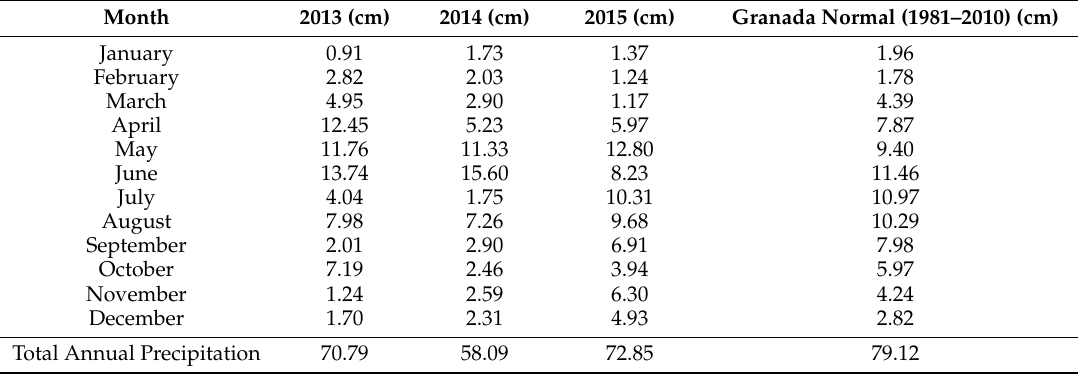
Table 6. Monthly rainfall totals during the years 2013–2015 with comparison to the Normal (30 year average) for Granada, Minnesota.